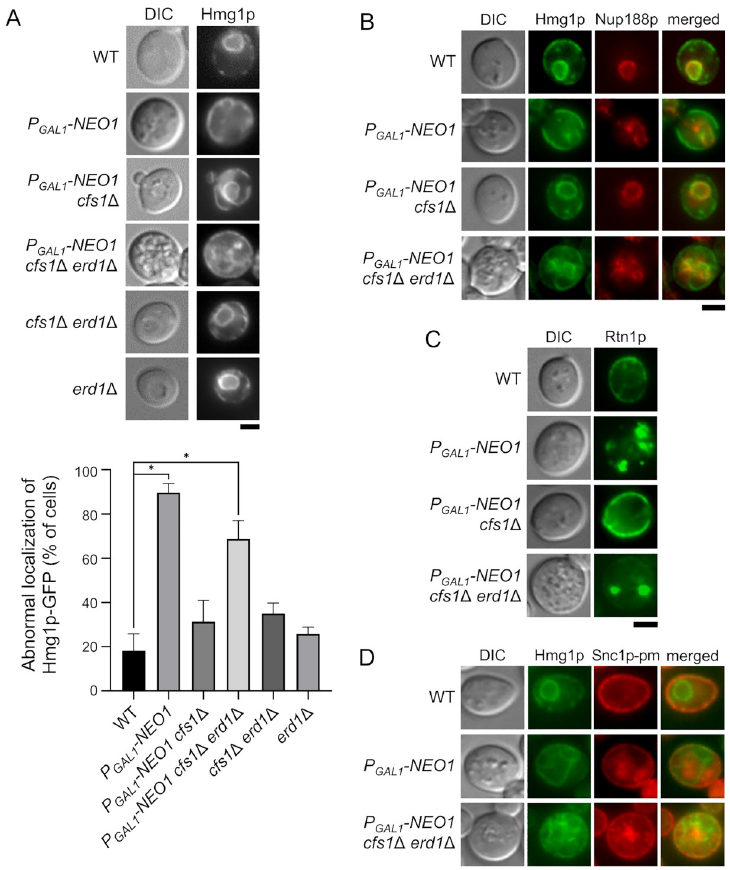
Fig 6. Disorganization of the ER structure in the Neo1p-depleted cfs1 Δ erd1 Δ mutant. (A) Localization of Hmg1p- GFP. Upper panel : Strains expressing Hmg1p-GFP were cultured in YPDA as in Fig 1C. The strains used were wild type (WT) (YKT2183), P GAL1 - NEO1 (YKT2184), P GAL1 - NEO1 cfs1 Δ (YKT2185), P GAL1 - NEO1 cfs1 Δ erd1 Δ (YKT2186), cfs1 Δ erd1 Δ (YKT2187), and erd1 Δ (YKT2188), all of which carry HMG1 - GFP . Lower panel : The percentage of cells that lacked perinuclear localization of Hmg1p-GFP was determined ( n = 200) and is expressed as the mean ± standard deviation of five independent experiments. Asterisks indicate a significant difference, as determined by the Tukey– Kramer test ( � : p < 0.01). (B) Localization of Nup188p-mRFP1. Cells were cultured in YPDA as in Fig 1C. The strains used were WT (YKT2189),